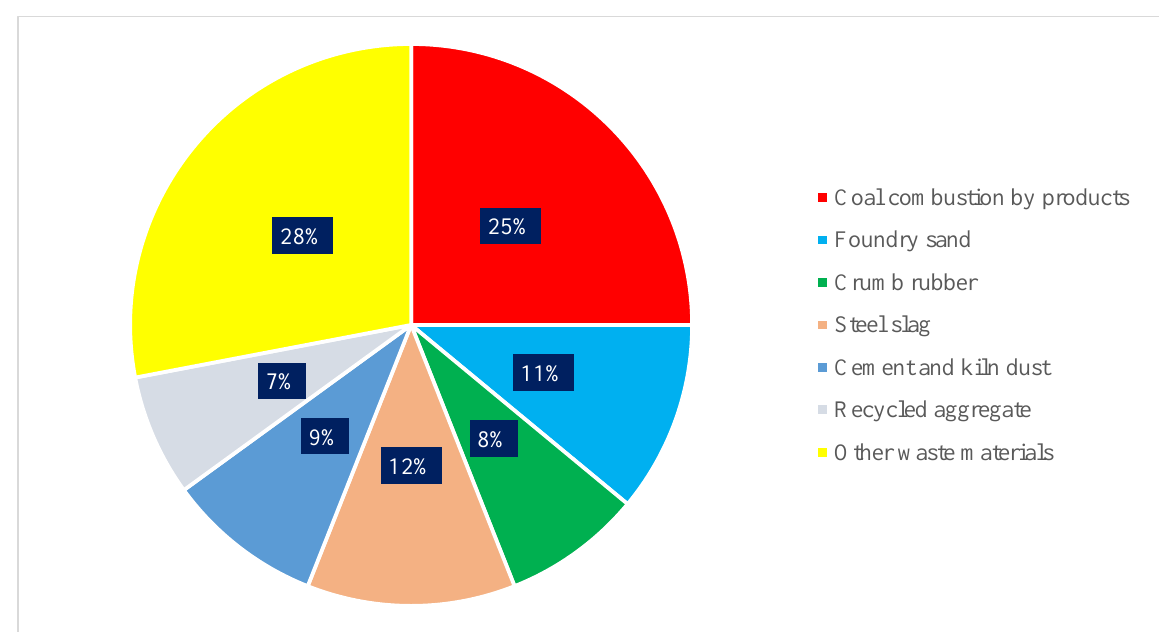
Figure 1. Utilization of different waste materials: data source [6].